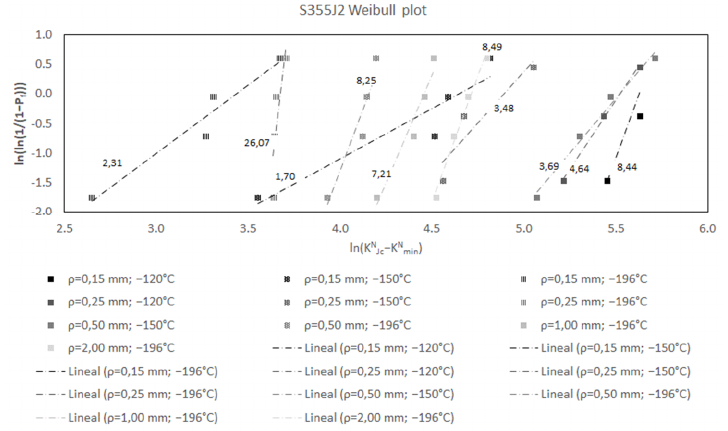
Figure 1. Statistical distribution of K NJc values determined from the three-parameter Weibull func- tion for steel S275JR.